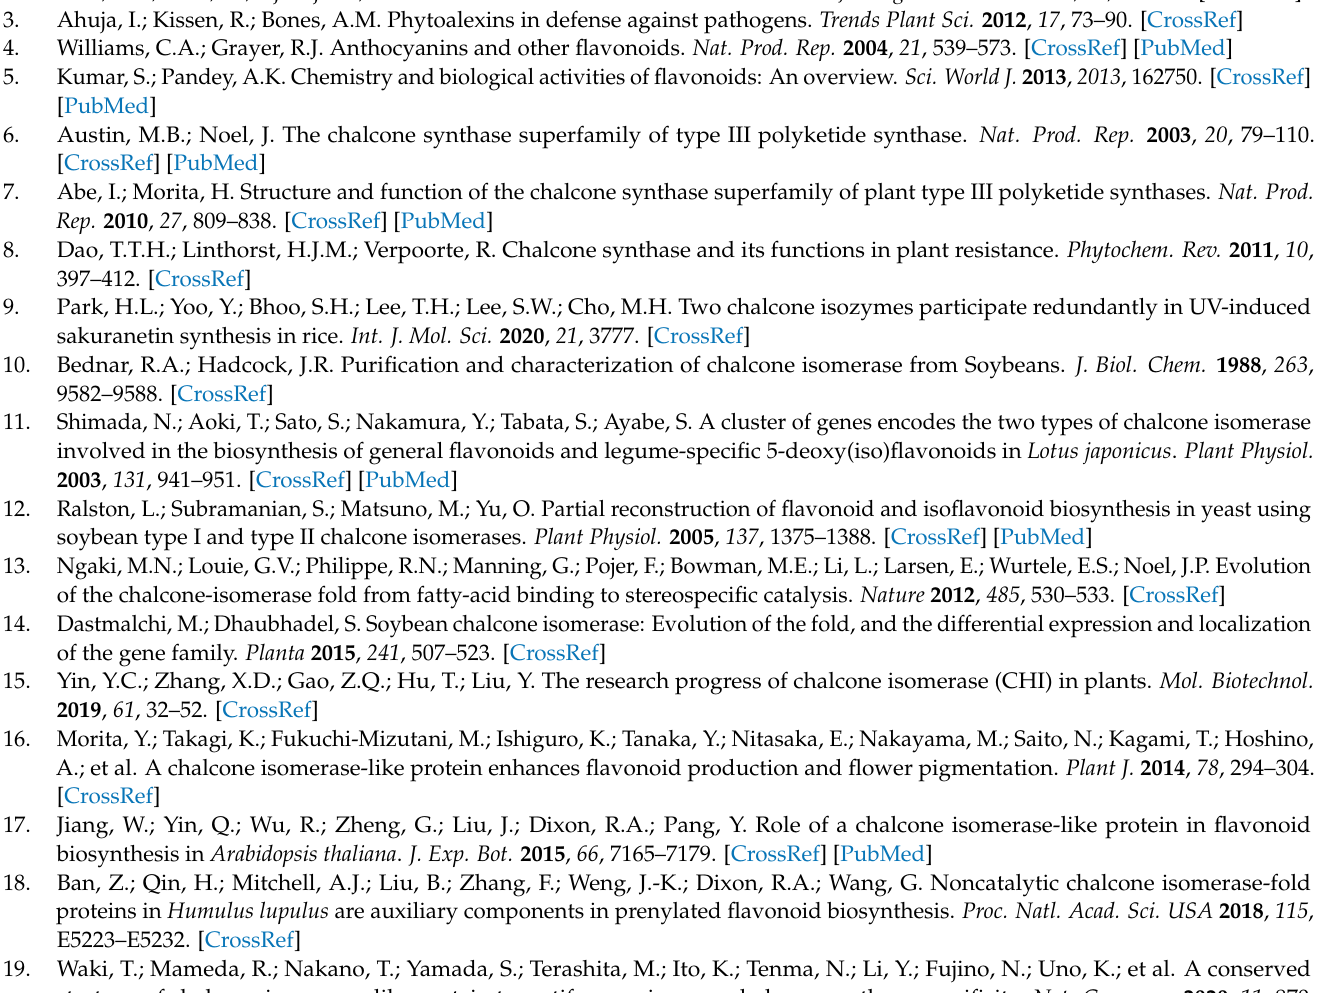
Purification of recombinant OsCHSs expressed in E. coli , Figure S3: CHI activity assay of recombinant OsCHI3, Figure S4: CHI activity assay of recombinant OsCHI1, OsCHI6, and OsCHI7, Figure S5: qRT-PCR analysis of OsCHI gene expression in rice seedlings and different tissues, Figure S6: HPLC analysis of UV-treated (a) and untreated (b) rice leaves, Figure S7: Expression of OsCHI s in rice leaves in response to UV treatment was analyzed using qRT-PCR, Table S1: Amino acid homology of OsCHIs and bona fide CHIs, Table S2: Primer sequences and PCR conditions for OsCHI cloning, Table S3: Primer sequences and PCR conditions for quantitative real-time PCR